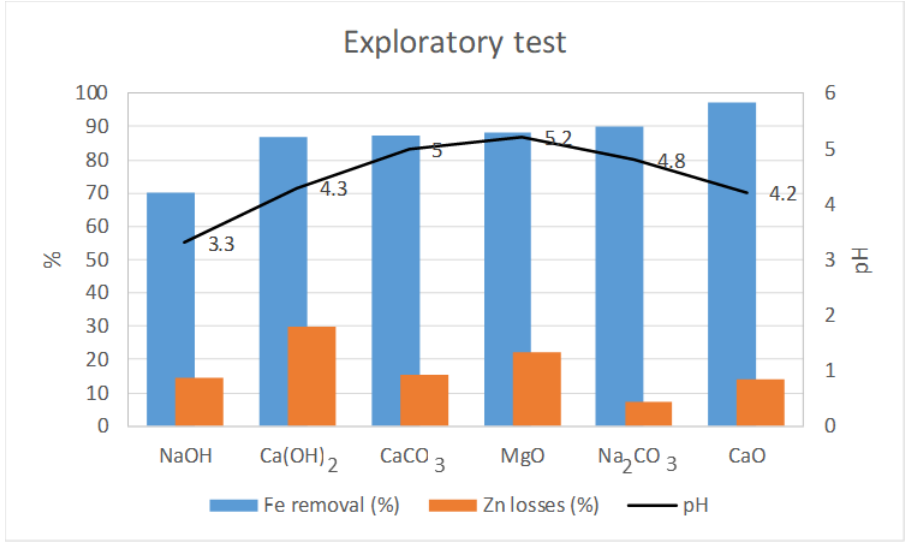
Figure 12. Exploration test results summary .